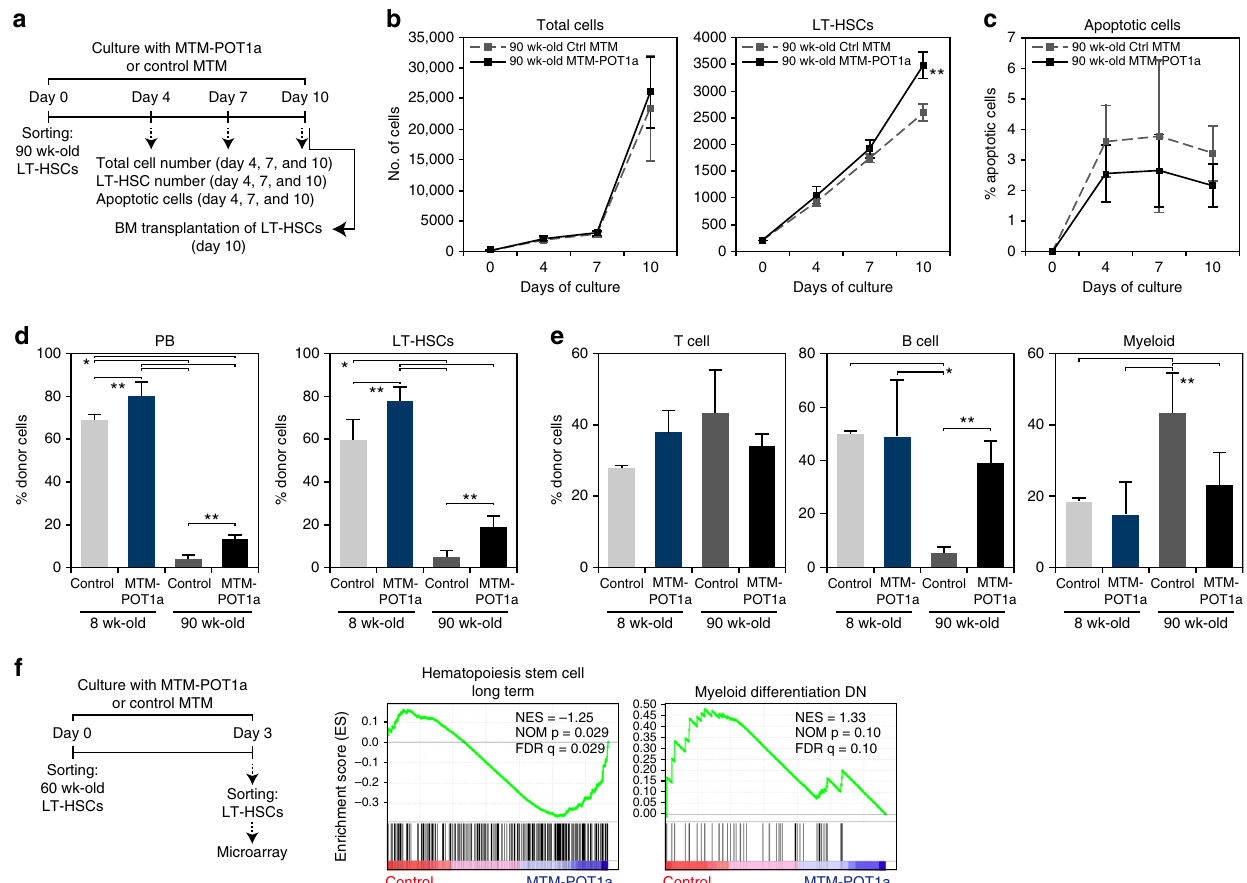
Fig. 8 MTM-POT1a improves aged HSC function. a Schematic of the analysis of cell number and apoptotic fraction of 90 week-old LT-HSCs after culture with MTM-POT1a or control MTM protein. b Number of total cells and LT-HSCs on days 4, 7, and 10 of culture. Data are expressed as the mean ± SD ( n = 5: day 4, n = 6: day 7 and 10, ** p < 0.05 by t -test). c Percentage of Annexin V + PI + apoptotic cells in LT-HSC fraction on day 4, 7, and 10 of culture. Data are expressed as the mean ± SD ( n = 6 – 8). d , e Effect of MTM-POT1a on reconstitution after BMT of young and aged LT-HSCs. 8 and 90 week-old LT-HSCs were cultured with MTM-POT1a or control MTM protein for 10 days and transplanted into lethally irradiated mice. d Percentages of donor- derived (Ly5.1 + ) cells in PB and LT-HSCs 4 months after BMT are shown ( n = 5 per group, * p < 0.01, ** p < 0.05 by Tukey ’ s test). Representative data from two independent experiments are shown. e Percentage of T cells (CD3 + ), B cells (B220 + ), and myeloid (Mac-1 + /Gr-1 + ) cells in donor-derived cells in PB ( n = 5 group – 1 , * p < 0.01, ** p < 0.05 by Tukey ’ s test). Representative data from 2 independent experiments are shown. f 60 week-old LT-HSCs were cultured with MTM-POT1a or control MTM protein for 3 days. After the culture, gene expression pro fi les were analyzed by microarray. GSEA plots demonstrating enrichment levels of indicated gene sets in control MTM protein treated cells versus MTM-POT1a treated cells. NES, NOM P value, and FDR are